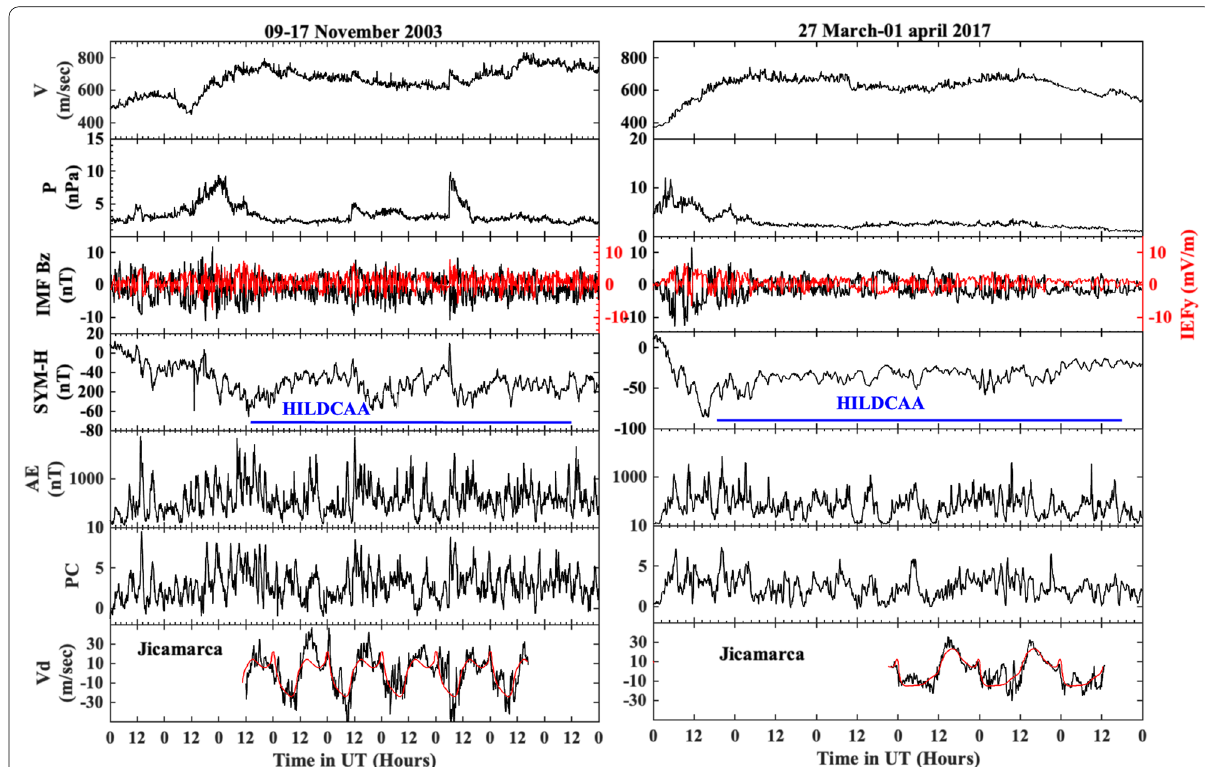
Fig. 1 Solar wind, geomagnetic and ionospheric drift measurements over low-latitude during two HILDCAA events on 09–17 November 2003 (left panel) and 27 March-01 April 2017(right panel). From top to bottom, the panels show the temporal variations of solar wind velocity (V), dynamic pressure (P), IMF Bz, and IEFy in GSM co-ordinate system, SYM-H, AE, PC index, and vertical drift over Jicamarca ( V d ) with the quiet time variation (red). The horizontal blue lines in the 4th panel indicate the duration of the HILDCAA